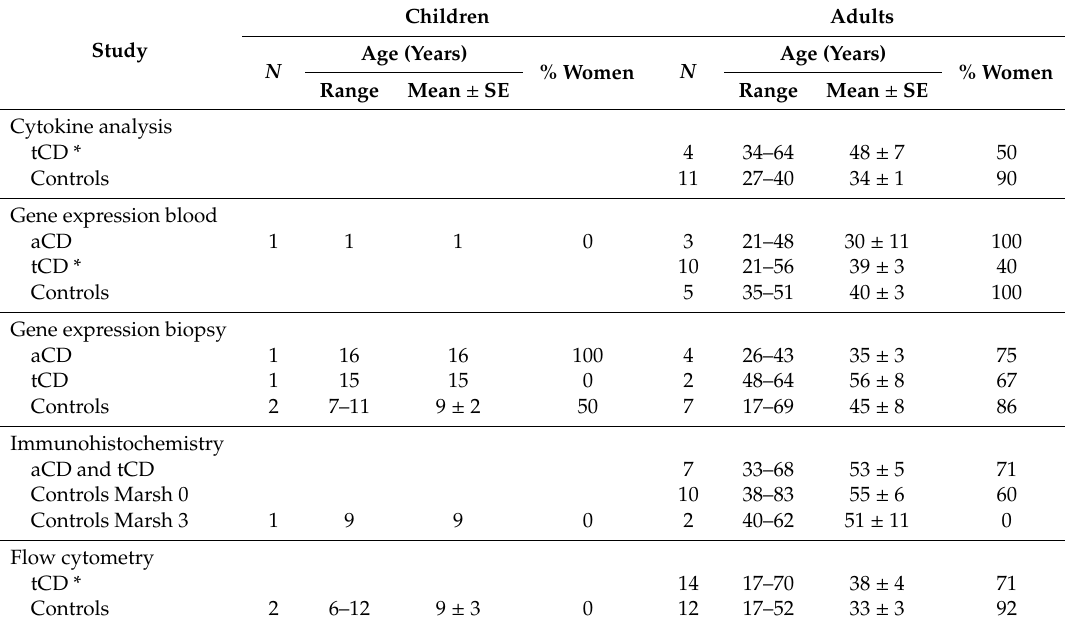
Table 1. Age and sex of the studied